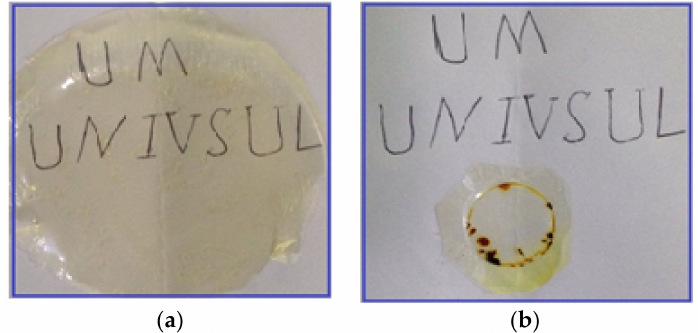
Figure 1. ( a ) Image of the fabricated solid polymer electrolyte (SPE). ( b ) Circle image of the fabricated SPE after linear sweep voltammetry (LSV)